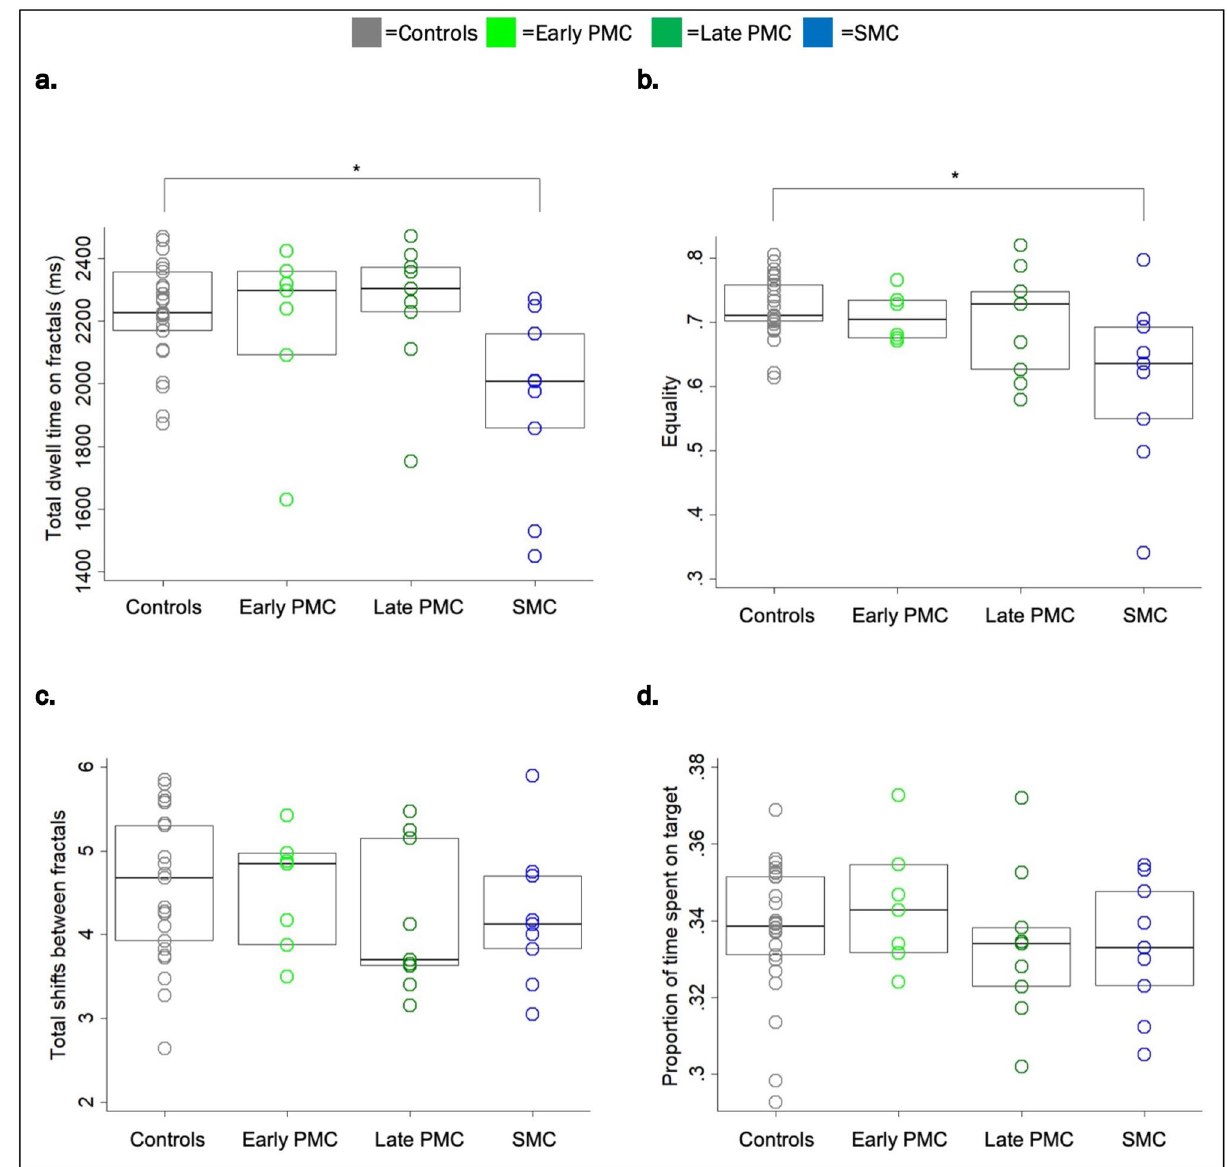
Figure 3. Visual exploration metrics by group. Unadjusted mean values. Each data point represents one participant, box represents median and interquartile range (IQR). ( a ) Total dwell time on fractals. ( b ) Equality index. Note that the x-axis does not start with zero. ( c ) Total shifts between fractals. ( d ) Proportion of time spent on the target fractal (unknown to the participant). PMC presymptomatic mutation carrier, SMC symptomatic mutation carrier. *Significant at p <